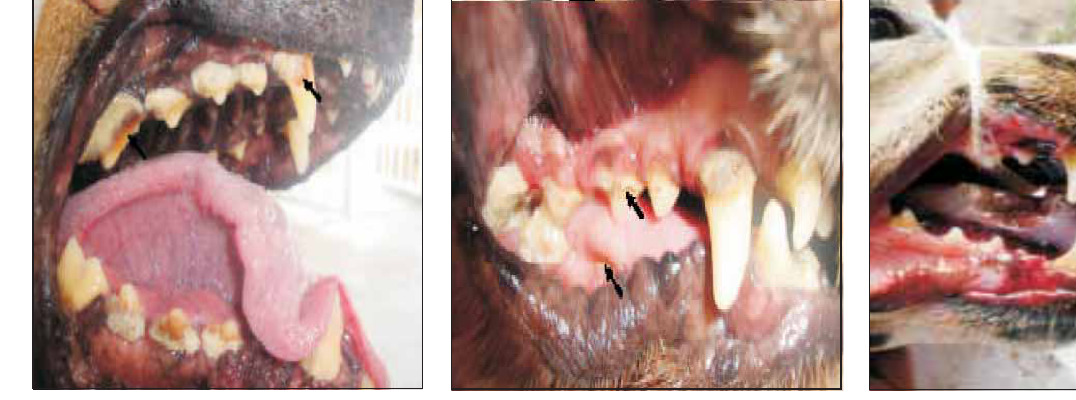
Figure-5: Ulcerative lesion in tongue in dog suffering from chronic renal